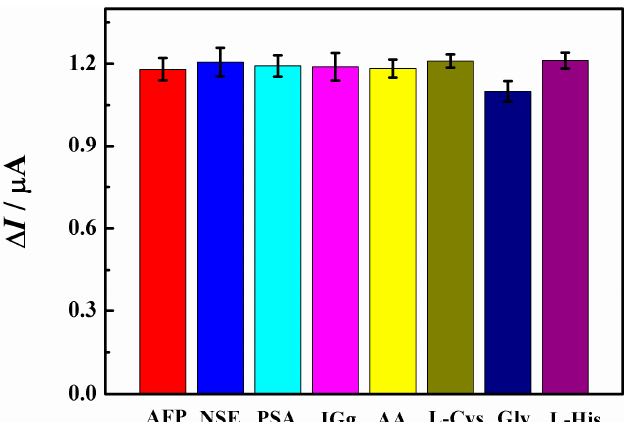
Figure 10. Electrochemical responses of the imprinted sensor toward 1.0 ng mL − 1 AFP in the presence of 50 ng mL − 1 NSE, PSA, IGg, AA, L-Cys, Gly and L-His.